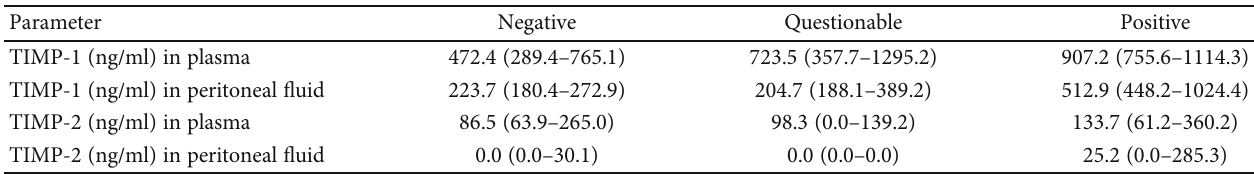
Table 5: TIMP-1 and TIMP-2 concentrations in plasma and peritoneal fl uid in the groups negative ( n = 32 , ≤ 6/19 points), questionable ( n = 8 ,